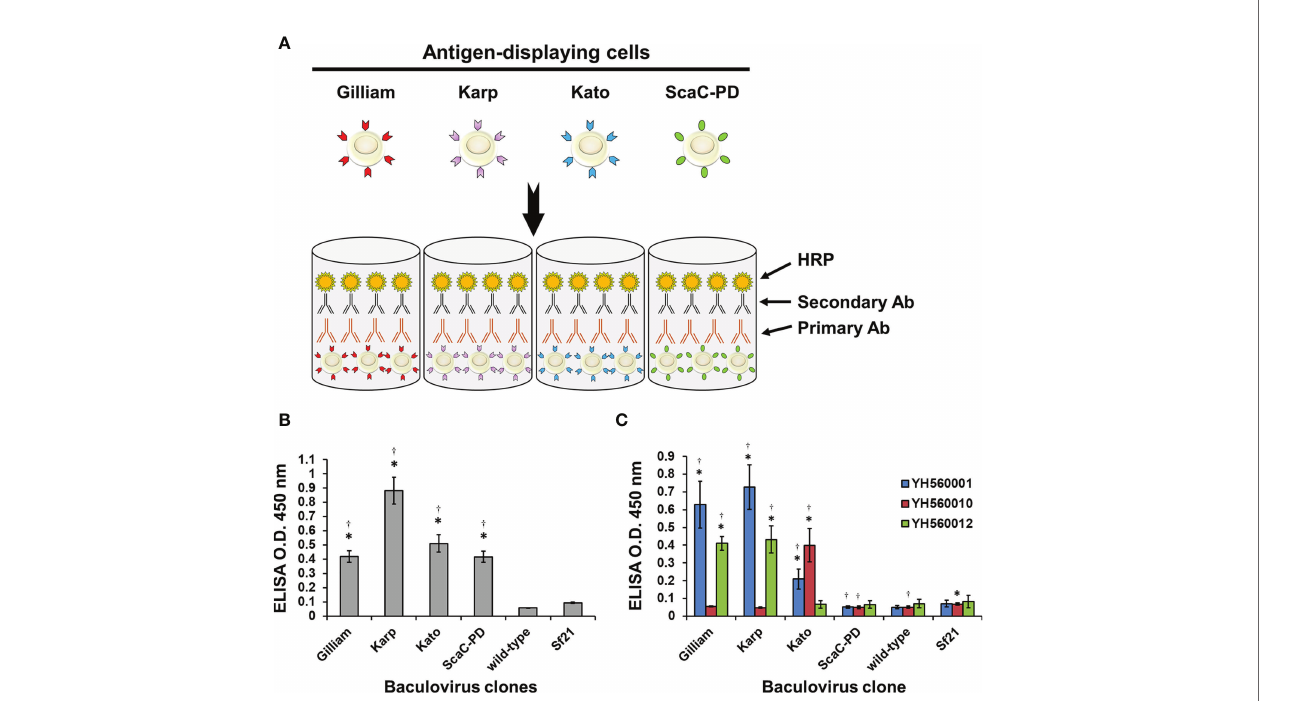
FIGURE 5 | Validation of our cell-based ELISA using anti-His and anti-TSA56 monoclonal antibodies. (A) Schematic illustration of our cell-based ELISA. Sf21 cells infected by baculoviruses expressing TSA56 or ScaC-PD gene constructs were seeded into micro-well plates and treated with primary antibodies (Primary Ab) before adding secondary antibodies (Secondary Ab) that are conjugated with horseradish peroxidase (HRP). Cell-based ELISA treated with anti-His antibody (B) or commercial anti-TSA56 monoclonal antibodies YH560001, YH560010, or YH560012 (C) . Wild-type: cells infected with wild-type baculovirus. Sf21: Sf21 cells not subjected to virus infection. ELISA reads are expressed as mean ± standard deviation (SD) of three replicates. Statistical signi fi cance was determined by Student ’ s t -test. *signi fi cant difference ( p <0.05) versus the value for wild-type. † signi fi cant difference ( p < 0.05) versus non-infected Sf21